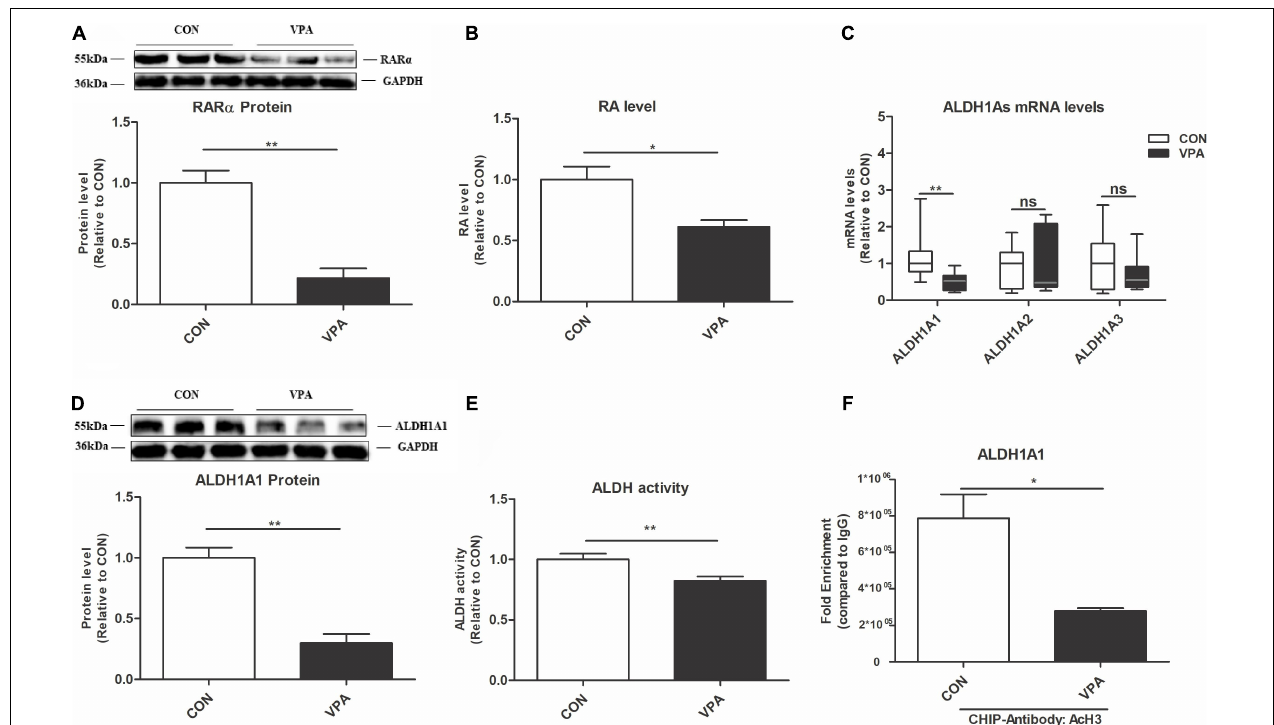
FIGURE 4 | Changes in ALDH1A1 and RA-RAR α in the PFC of VPA-exposed offspring. (A) Western blot and quantification analyses of RAR α protein in the PFC from the CON and VPA groups ( n = 3 per group). (B) RA levels in the PFC from CON and VPA groups, as quantitated using UPLC-MS/MS ( n = 5 per group). (C) ALDH1A1, ALDH1A2, and ALDH1A3 mRNA expression levels in the PFC from the CON and VPA groups, as detected using qPCR and normalized to GAPDH ( n = 10 per group). (D) Western blot and quantification analyses of ALDH1A1 protein in the PFC of offspring from the CON and VPA groups ( n = 3 per group). (E) ALDH enzyme activity in PFC tissue from the CON and VPA groups was determined using an ALDH Assay Kit ( n = 10 per group). (F) ChIP-qPCR analyses of the enrichment of AcH3 on the promoter region of the ALDH1A1 gene in the PFC from the CON and VPA groups ( n = 3 per group). Each experiment was repeated at least three times. The values are the means ± SEMs (A,B,D–F) or median (P25–P75) (C) . Student’s t -test (A,B,D–F) , Mann–Whitney U test (C) , * P < 0.05, ** P < 0.01, ns, not significant; VPA, valproic acid; PFC: prefrontal